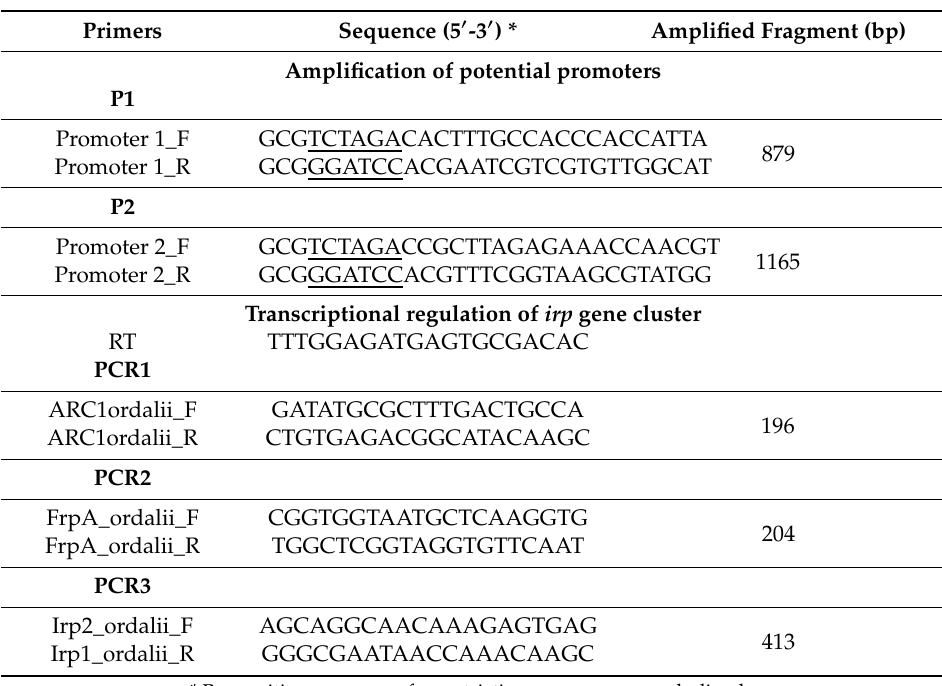
Table 1. Primers used in this